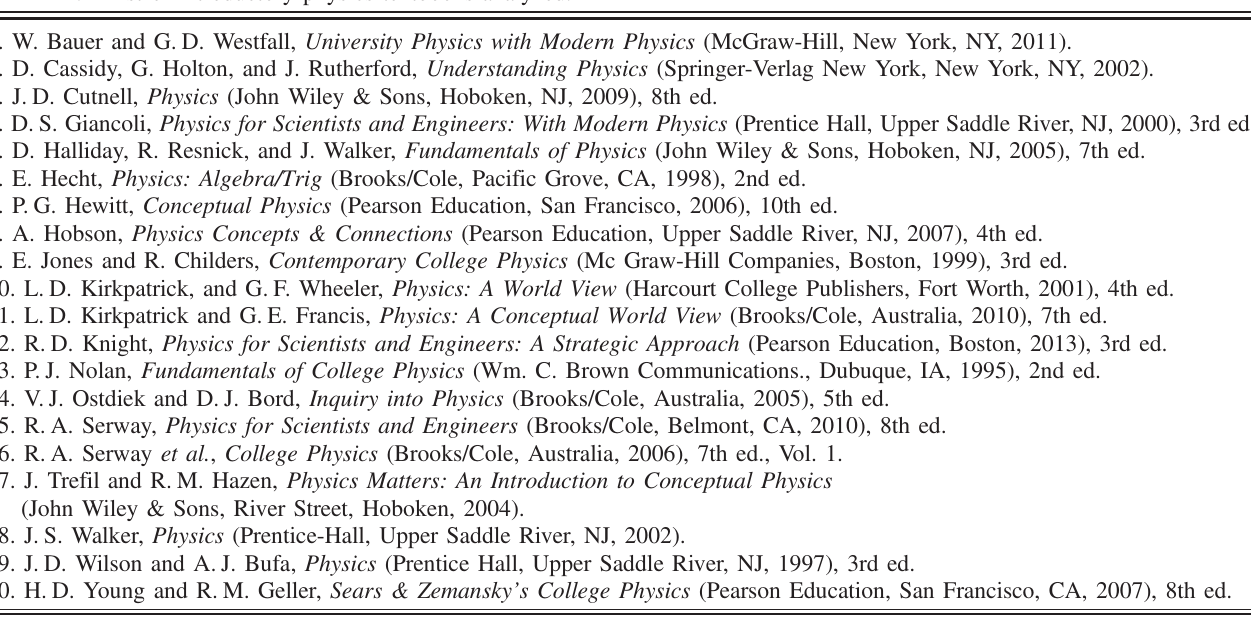
TABLE I. List of introductory physics textbooks